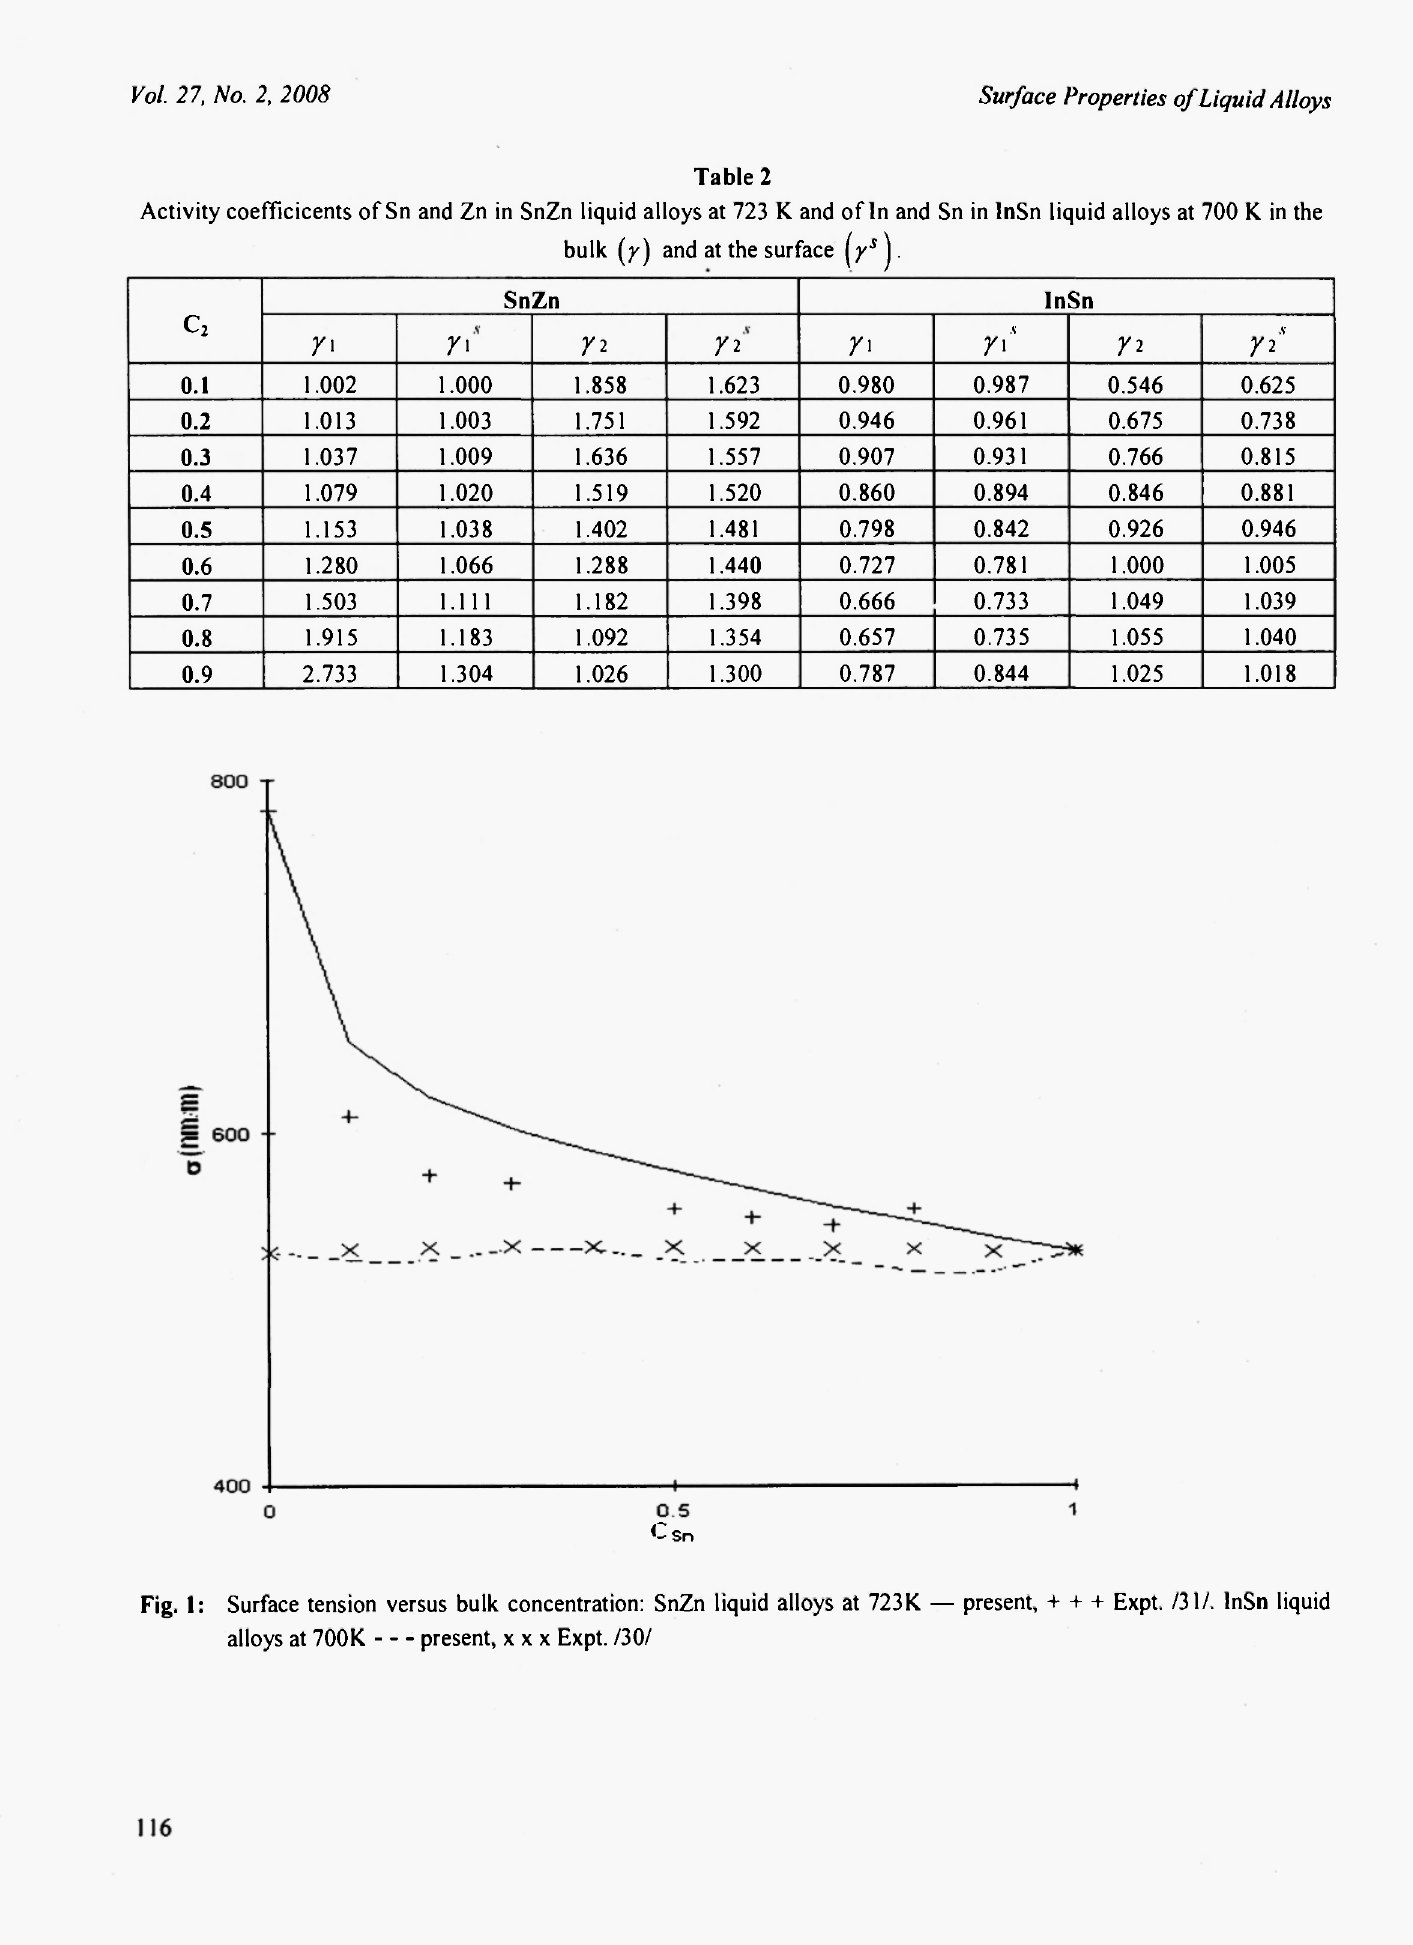
Surface tension versus bulk concentration: SnZn liquid alloys at 723K — present, + + + Expt. /31/. InSn liquid alloys at 700K present, χ χ χ Expt.